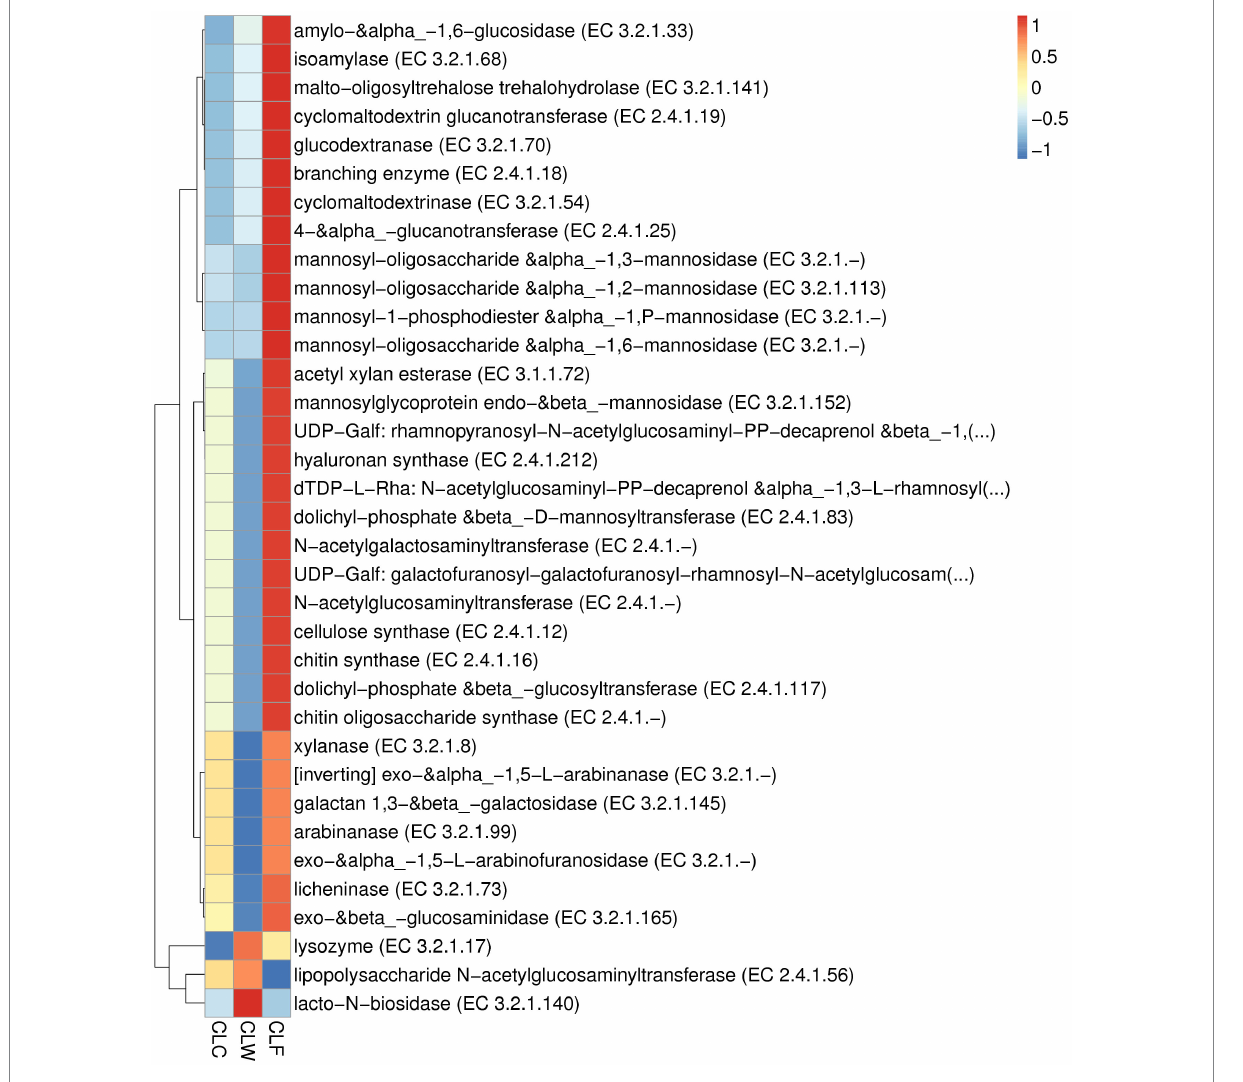
FIGURE 8 Heat map showed the difference in functional abundance of groups CLW, CLC and CLF annotated at CAZy level